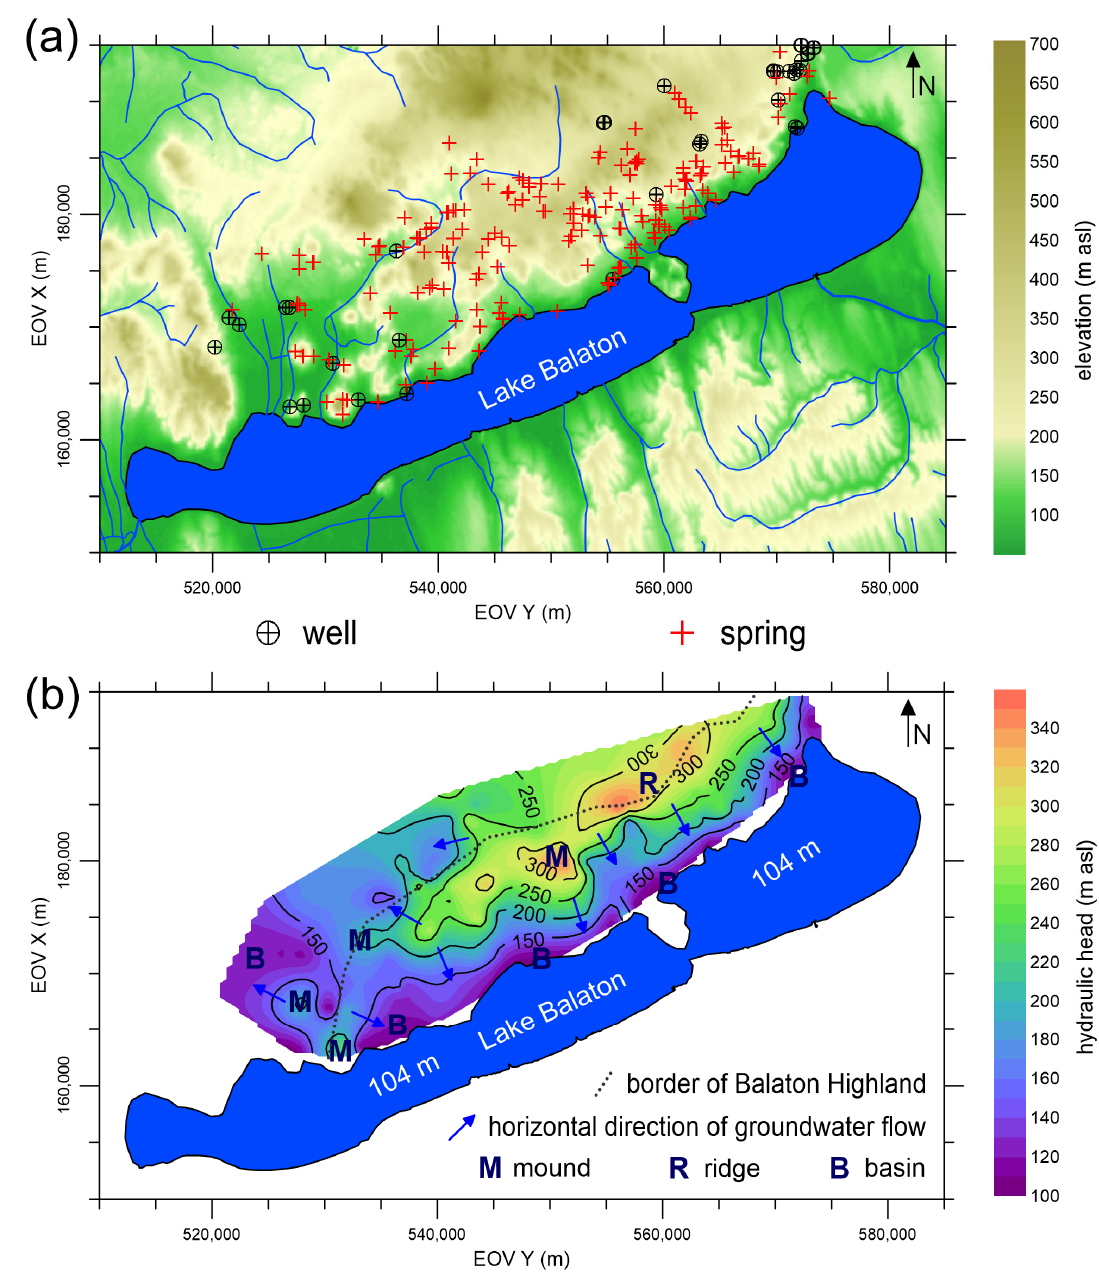
Figure 4. Hydraulic head distribution. ( a ) Topographic map for reference showing the data source and its distribution; ( b ) hydraulic head map with the interpreted horizontal groundwater flow directions and hydraulic features (mound, ridge, basin).